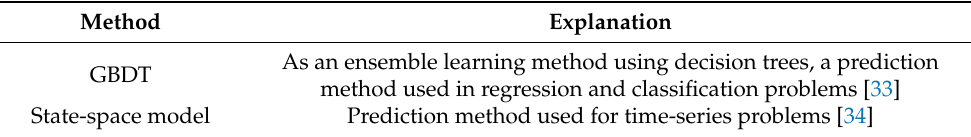
Figure 6. Overview of state-space model. Table 7. Methods selected as a candidate for rack intake temperature prediction model.